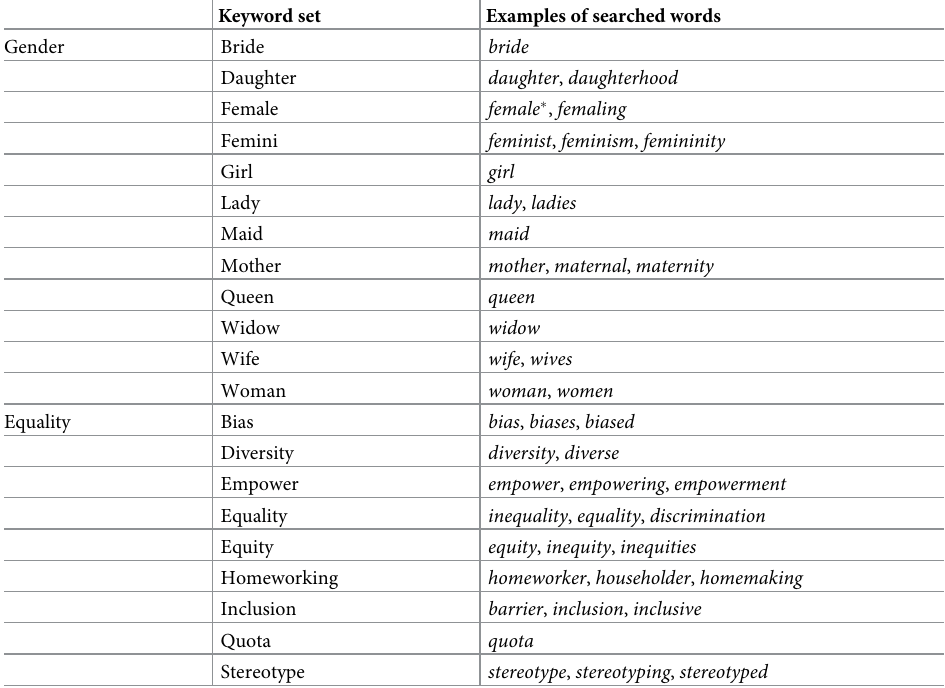
Table 1. Examples of keywords used to identify gender-related papers relevant for the aim of the literature review. Keyword